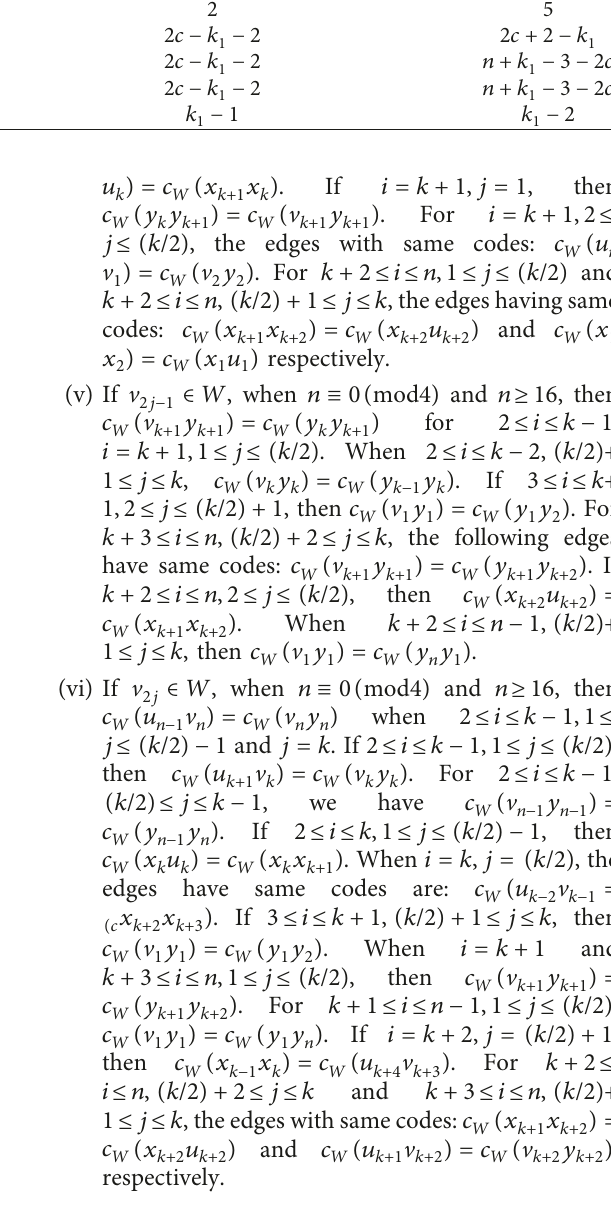
Table 39: Codes of edges, e � u